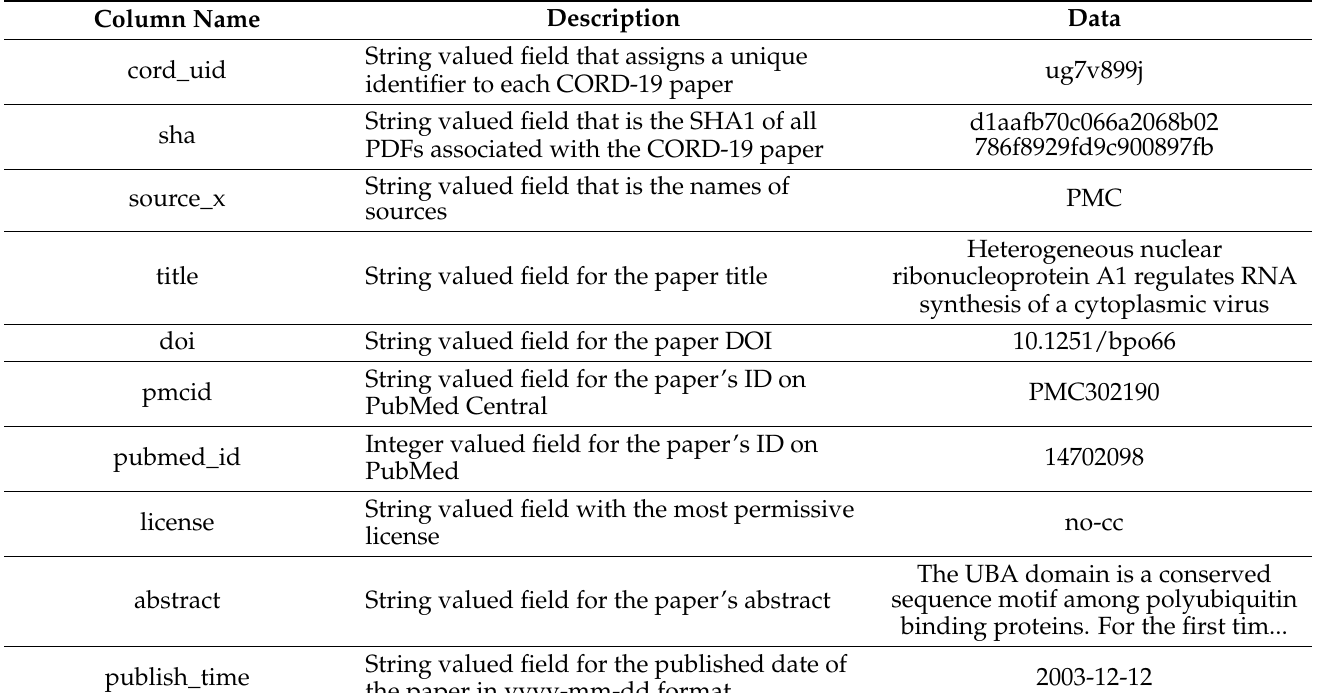
Table 3. Example data from CORD-19